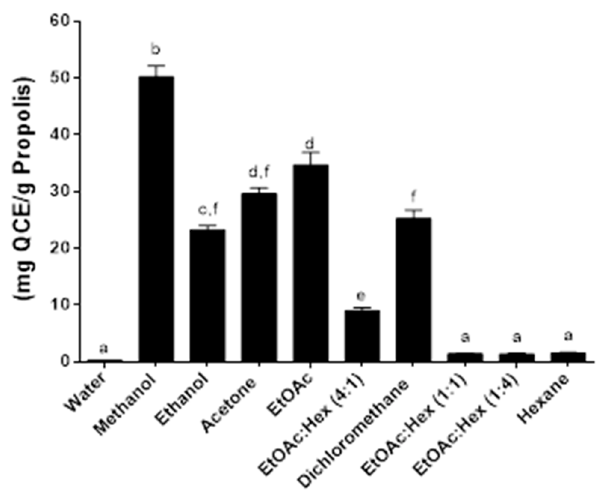
Figure 5. Total flavonoid content following MAE. Values are the means ± SEM of at least three independent experiments, each performed in duplicate; values with different superscripts are significantly different ( p < 0.05) as determined by one-way ANOVA test with subsequent Tukey’s adjustment; QCE: quercetin equivalent.